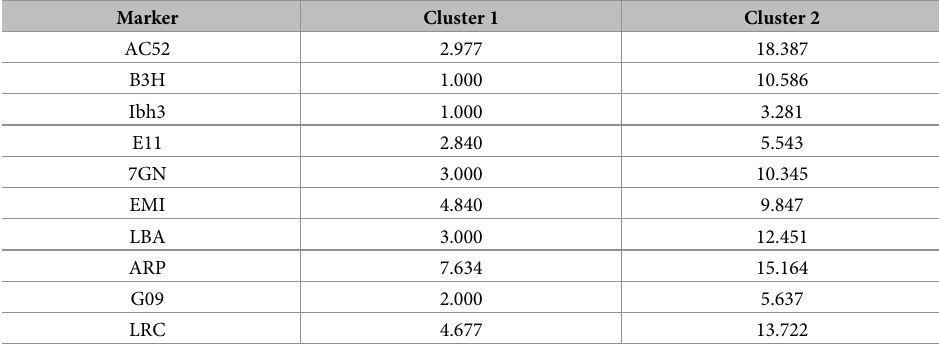
The results were determined with FSTAT 2.9.3.2.